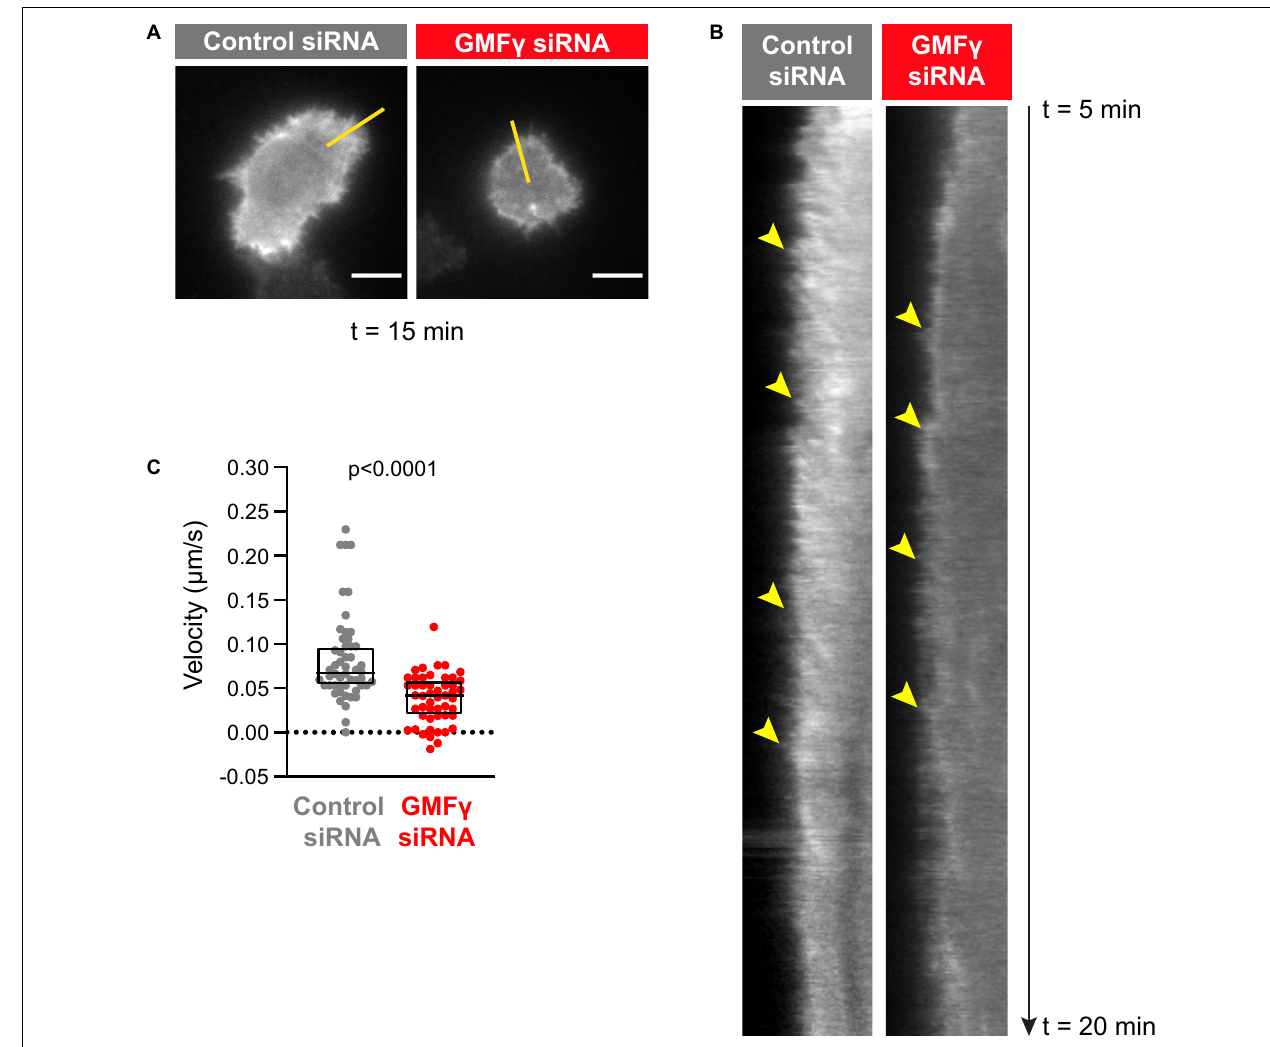
FIGURE 4 | Depleting GMF γ reduces the velocity of actin retrograde flow. Raji D.3 B cells that had been co-transfected with F-tractin-GFP cDNA and either control siRNA or GMF γ siRNA were added to anti-human IgM-coated coverslips and allowed to spread for 5 min. The cells were then imaged by TIRF microscopy at 2 s intervals for 15 min ( t = 5 min to t = 20 min). Video recordings of representative cells are shown in Supplementary Movie 1 (control siRNA) and Supplementary Movie 2 (GMF γ siRNA). (A) Still images of the control siRNA- and GMF γ siRNA-transfected cells shown in Supplementary Movies 1, 2 at t = 15 min. Scale bars: 5 µ m. (B) Kymographs were generated along the yellow lines in (A) . Arrowheads indicate the starting points of representative actin tracks for which centripetal velocities were determined. (C) The centripetal velocity ( (cid:49) x/ (cid:49) t) was calculated for individual actin tracks on the kymographs. Each dot on the graph is an individual actin track. The velocity was determined for 52 tracks from 9 cells (control siRNA) or 51 tracks from 11 cells (GMF γ siRNA). The Mann-Whitney U -test was used to calculate the p